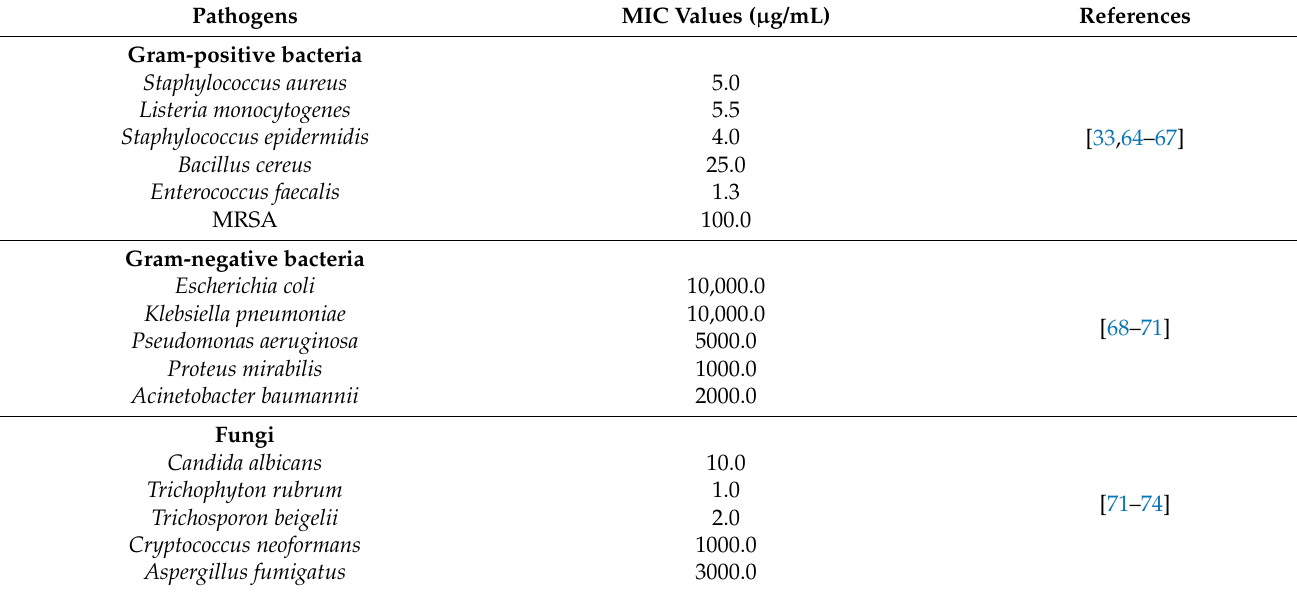
Table 2. Minimum inhibitory concentration (MIC) values of LEO against various pathogens obtained from different in vitro